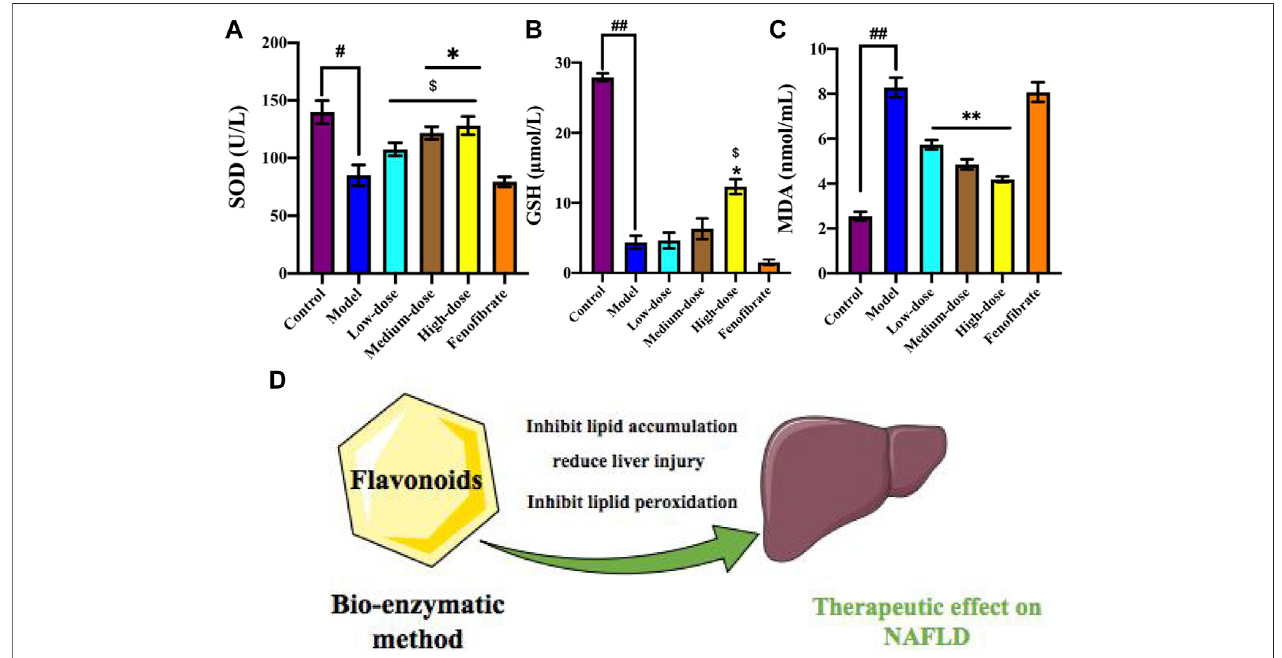
FIGURE 7 | Ey-TFH inhibit lipid peroxidation. (A) SOD; (B) GSH; (C) MDA. (D) The therapeutic effect of Ey-TFH on NAFLD. # p < 0.05, ## p < 0.01, compared with the control group; * p < 0.05, ** p < 0.01, compared with the model group; $ p < 0.05 compared with the positive control